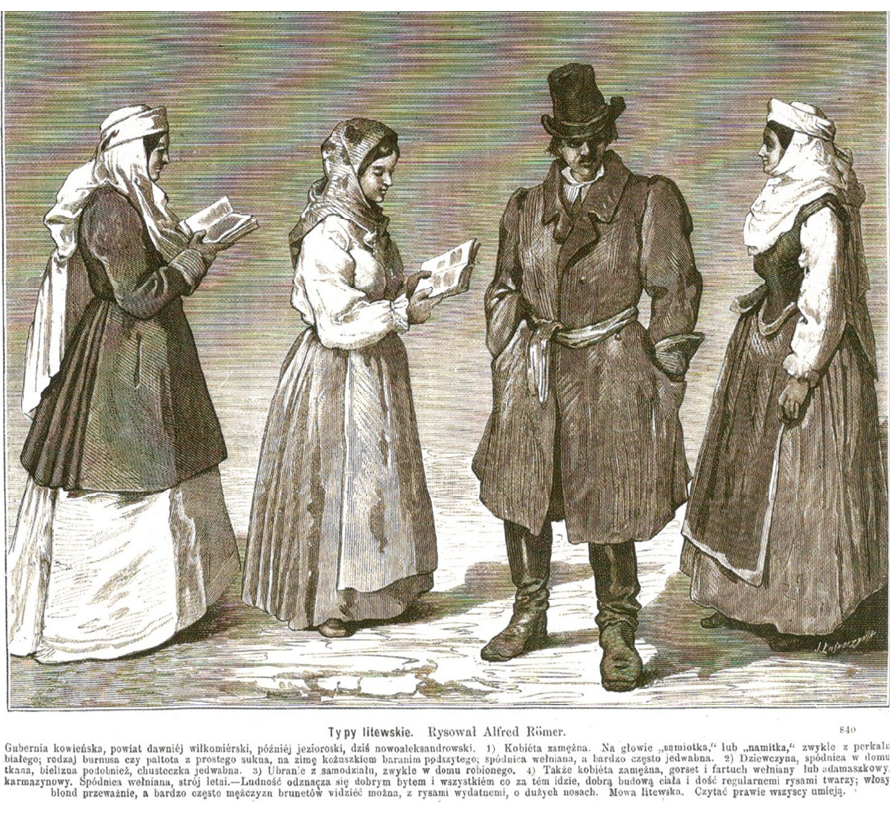
Figure 8. Lithuanian types [59].